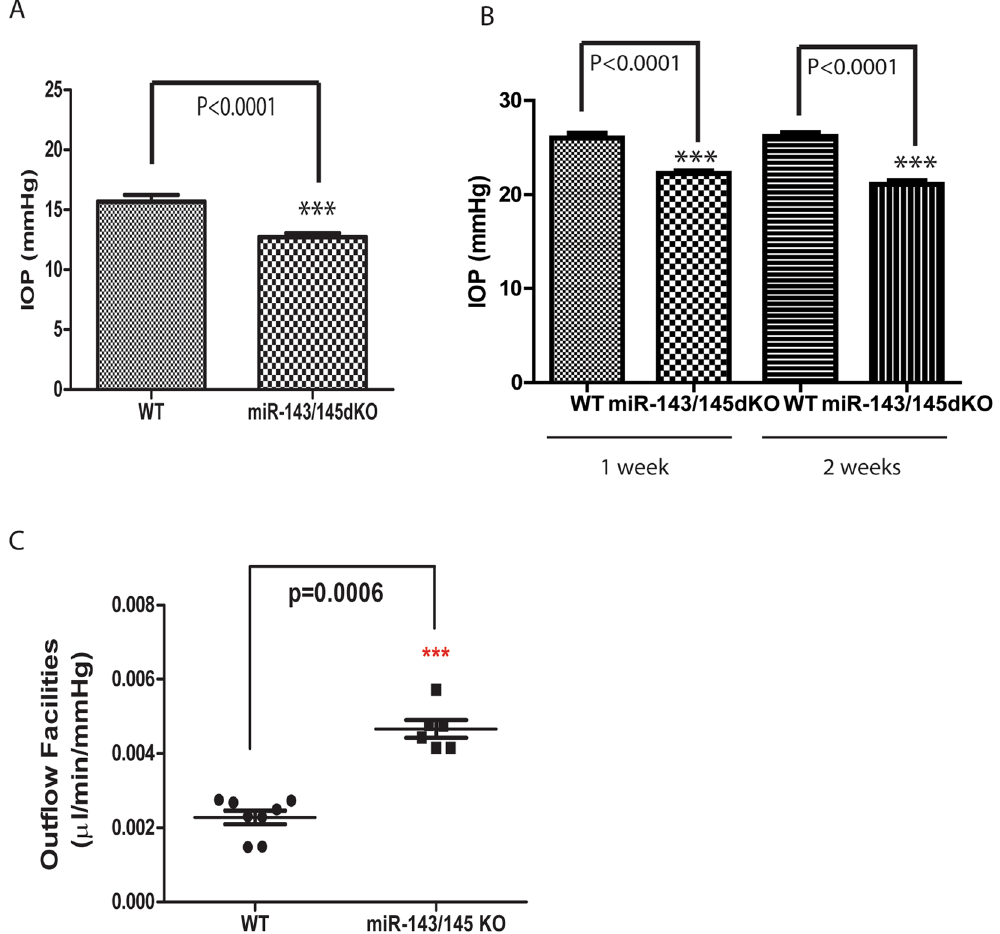
Figure 3. Reduced IOP and increased outflow facilities in miR-143 / 145 dKO mice. ( A ) Reduced intraocular pressure (IOP) in miR-143 / 145 dKO mice. *** p < 0.0001; ( B ) Reduced intraocular pressure in miR-143 / 145 dKO mice in an experimental glaucoma model. The IOP of the mice was measured at 1 and 2 weeks after microbeads injection into the eye. *** p < 0.0001; ( C ) Significant increase in outflow facilities in 16-month-old miR-143 / 145 dKO mice compared to that in WT control mice. *** p <